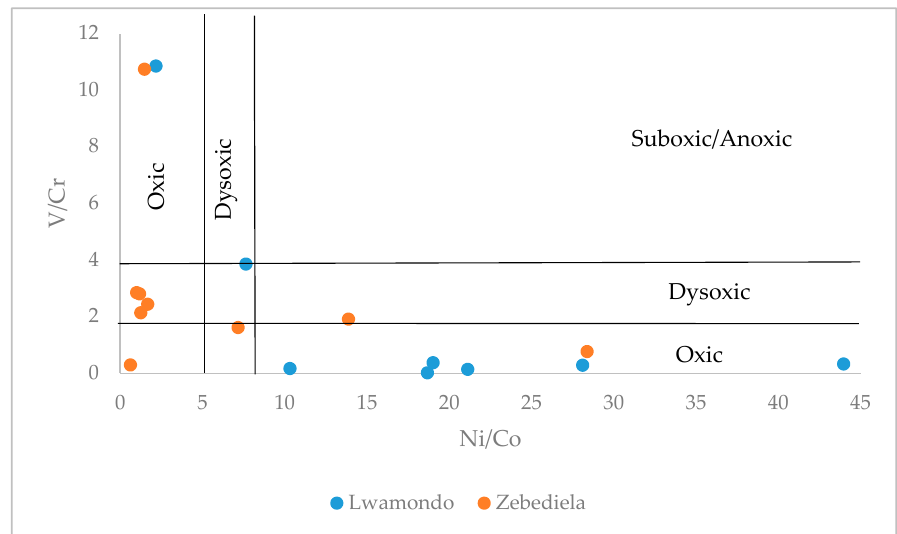
Figure 12. Cross plots of V/Cr vs. Ni/Co used as paleo-redox proxies.